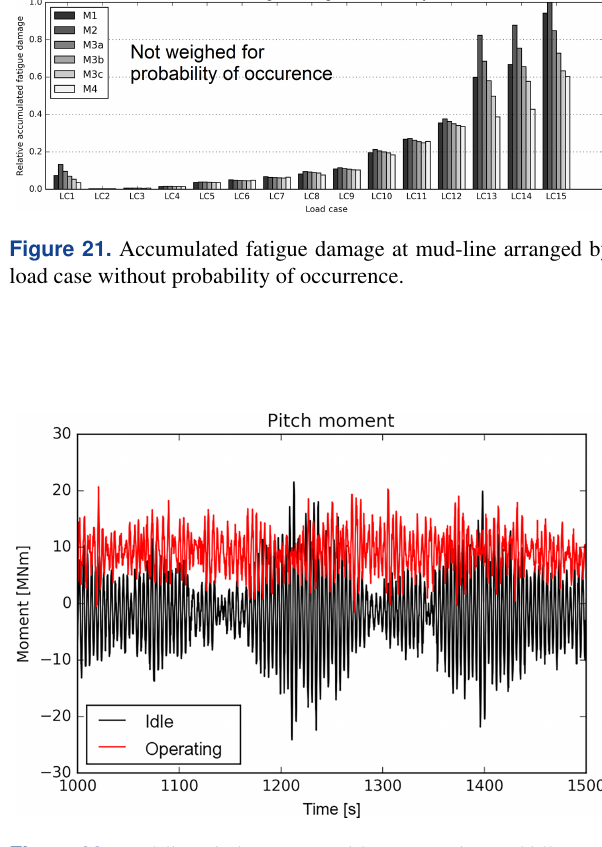
Figure 22. Mud-line pitch moment with an operating and idle rotor for load case 2.